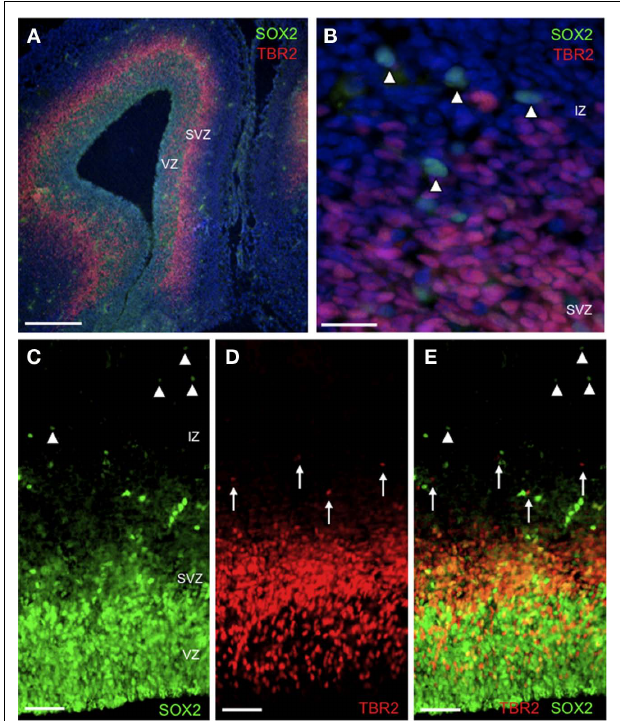
FIGURE 3 | Distribution of SOX2 andTBR2 in embryonic rat brain. Representative fluorescence microscopic images of E18 brain showing immunohistochemically detected SOX2 + andTBR2 + cells in the context of total cells [DAPI, blue, (A,B) only]. (A) Note the abundance of SOX2 + and TBR2 + cells in theVZ and SVZ respectively. Scale bar = 200 μ m. (B) Detail of image (A) showing extra-ventricular SOX2 + cells (arrowheads) in the IZ. Scale bar = 20 μ m. (C–E) Relative distribution of SOX2 + andTBR2 + cells in the IZ. Note that extra-ventricular SOX2 + cells (arrowheads) are distributed across the IZ (and beyond, see text) whereasTBR2 + cells (arrows) are restricted to the inner IZ. Scale bar = 50 μ m. Abbreviations: IZ, intermediate zone; SVZ, sub-ventricular zone;VZ, ventricular zone.